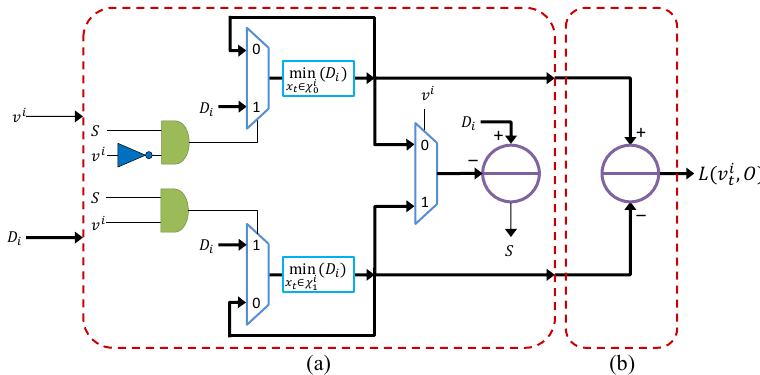
Figure 5. ( a ) Minimum finder operational unit; ( b ) subtractor used in the subtraction operation of the minimum